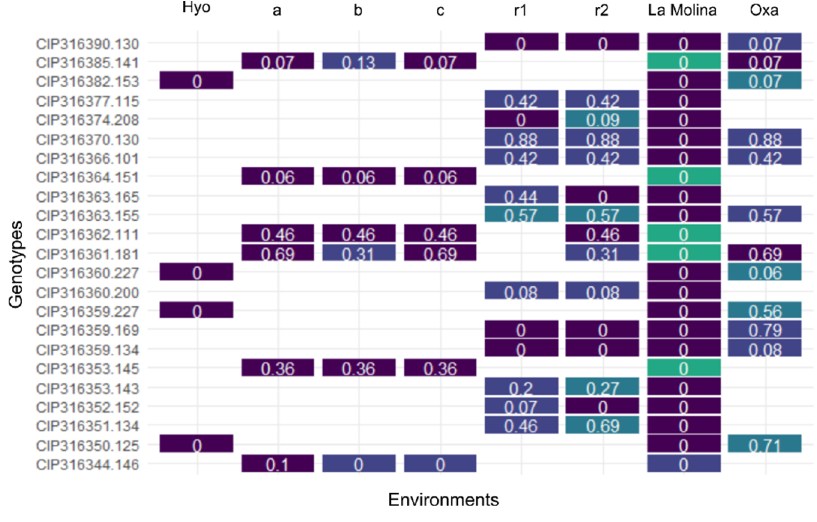
Figure 6. Proportion of dissimilarity between samples of clones taken from Hyo and Oxapampa and their corresponding reference genotypes grown in the greenhouse at La Molina. Among 114 samples, only those with at least one difference as compared with the La Molina samples were represented. Different colors in the same row denote a somewhat genetic distance (see Materials and Methods) between samples of the same clone. Environments are the locations or any specification within the Huancayo location where the samples were taken. Hyo, Huancayo intermediate trial, samples were taken from the first replication alone; a, b, and c represent the three samples taken within random plots in the first replication of Hyo; r1 and r2 denote the two different replications in Hyo; Oxa, the Oxapampa preliminary trial.